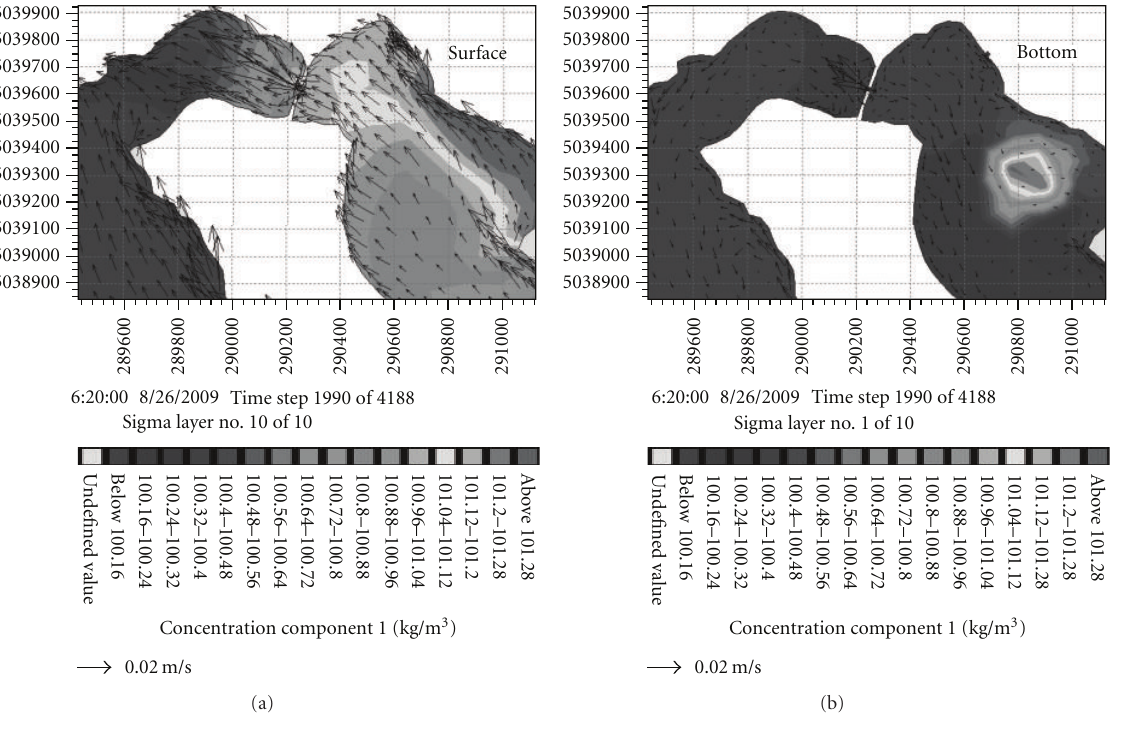
Figure 17: Simulated flow patterns in the causeway area on the Julian day 238.1 (having the strongest recorded east wind) with a 15-meter- wide opening in the middle of the causeway.